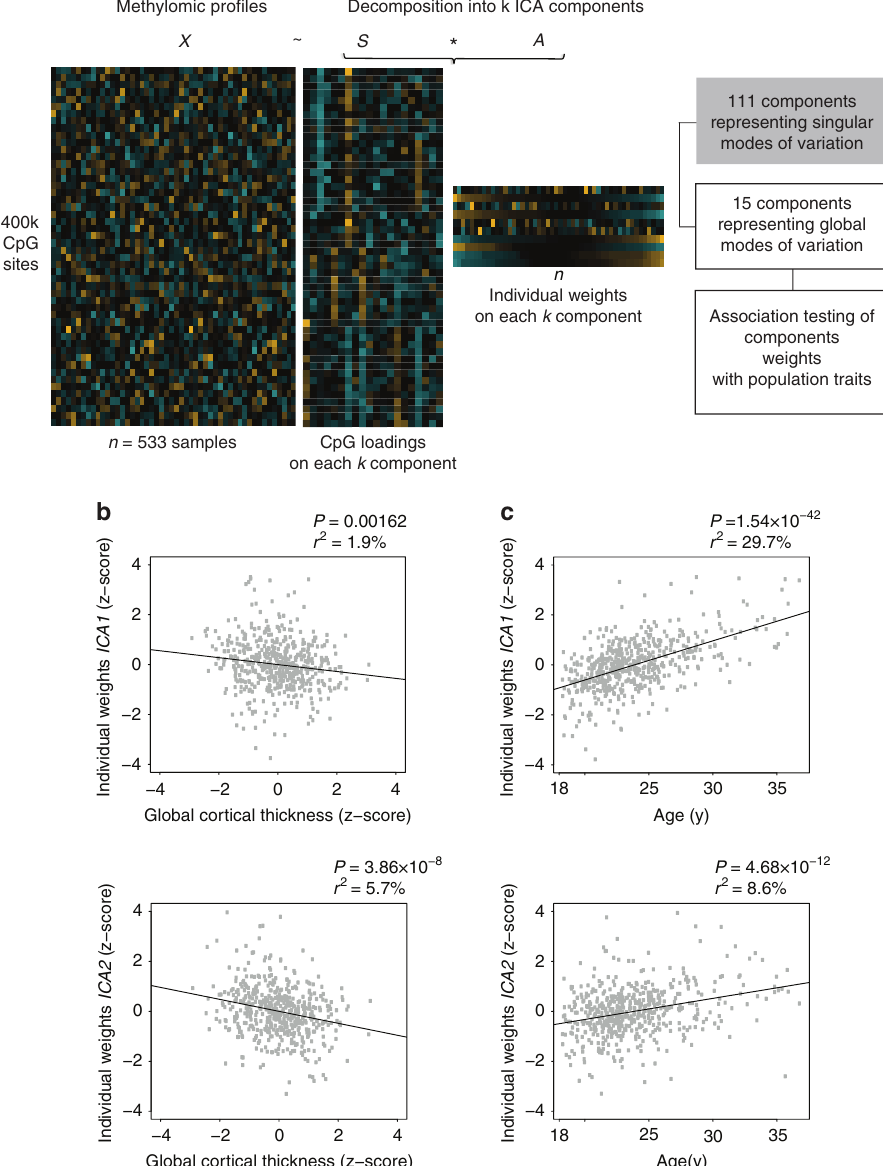
Figure 1 | ICA-based identification of DNAm patterns. ( a ) Schematic representation of the analysis workflow; ICA decomposition of genome-wide methylomic profiles (matrix X , n ¼ 533 samples (cid:2) 397,947 CpGs sites) into k independent components, simultaneously represented across CpGs (matrix S of CpGs loadings) and samples (matrix A of individual weights). A total of 15 components, whose corresponding weights represent global modes of DNAm across samples, were tested for association with cortical thickness and chronological age. ( b ) Two components, ICA1 and ICA2 , are significantly associated with cortical thickness. Horizontal axis: cortical thickness adjusted for sex, intra-cranial volume and MR-batches. Vertical axis: individual weights on ICA component. ( c ) ICA1 and ICA2 show significant association with chronological age. P : P value of association (Pearson’s correlation, two-sided test); r 2 : fraction of variance in component weights explained by chronological age (in %). NATURE COMMUNICATIONS|8:15193|DOI: